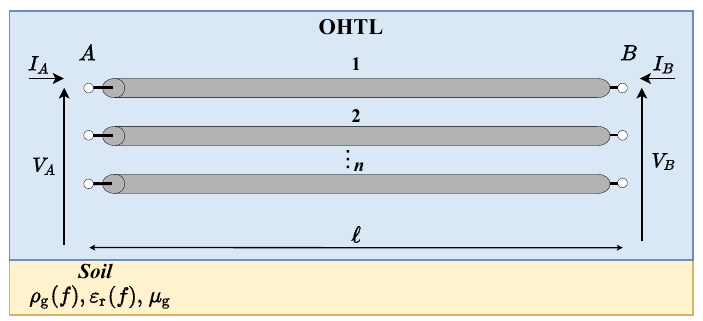
Figure 3. Multiphase OHTL of length (cid:96)